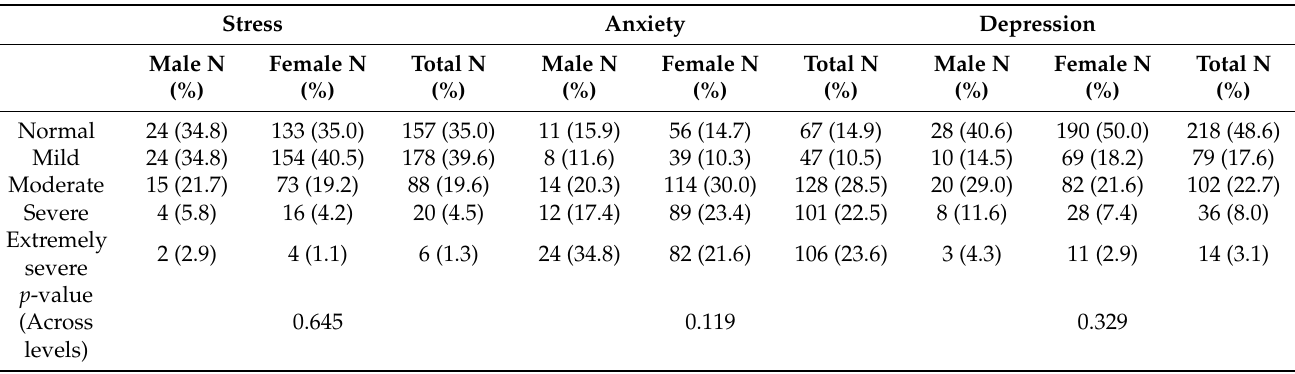
Table 3. Severity levels of depression, anxiety, and stress among the health science undergraduate students according to gender.